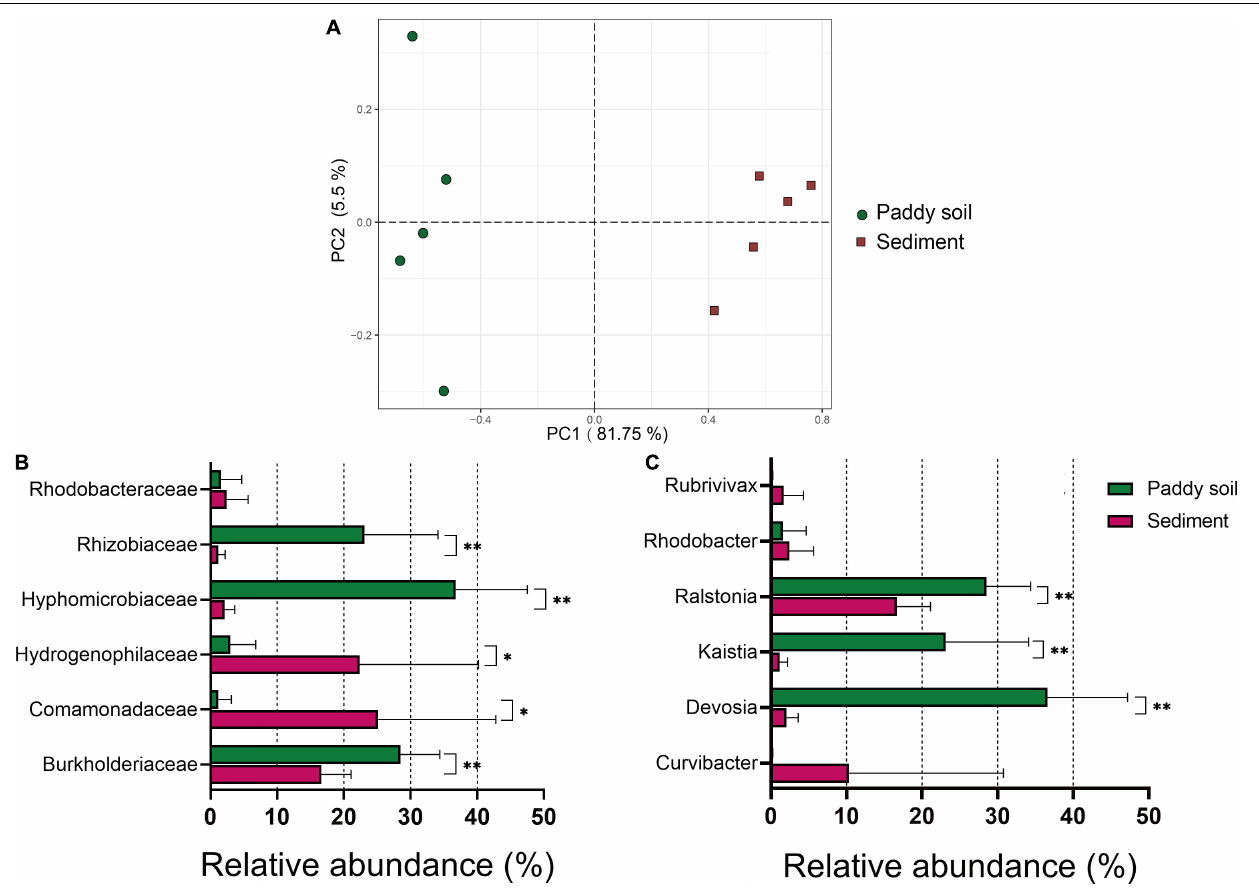
FIGURE 3 | Differences in the As(III)-oxidizing bacteria between the paddy soil and sediment samples. (A) Unweighted PCoA clustering of the As(III)-oxidizing community in the paddy soil (red circles) and sediment (blue squares) samples generated using the 1109F/1548R primer sets. The percentage variation in the plotted principal component is indicated on the axes. (B) Taxonomic composition of the As(III)-oxidizing bacteria at the family level. (C) Taxonomic composition of the As(III)-oxidizing bacteria at the genus level. The taxonomic composition of the aioA sequences in each sample was determined using the MEGAN software against the NCBI-nr with Diamond software at e < e–10 and an alignment length > 200 nt. The average ± SD values of the samples in each group are expressed in each column. The significance cutoff for the corrected P -value using the Benjamini–Hochberg false discovery rate (FDR) procedure is shown. Significant differences between the sampled groups are indicated as ∗∗ p < 0.01 and ∗ p <